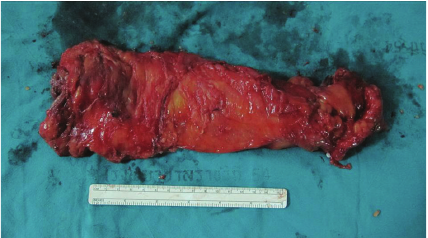
Figure 5: Specimen in